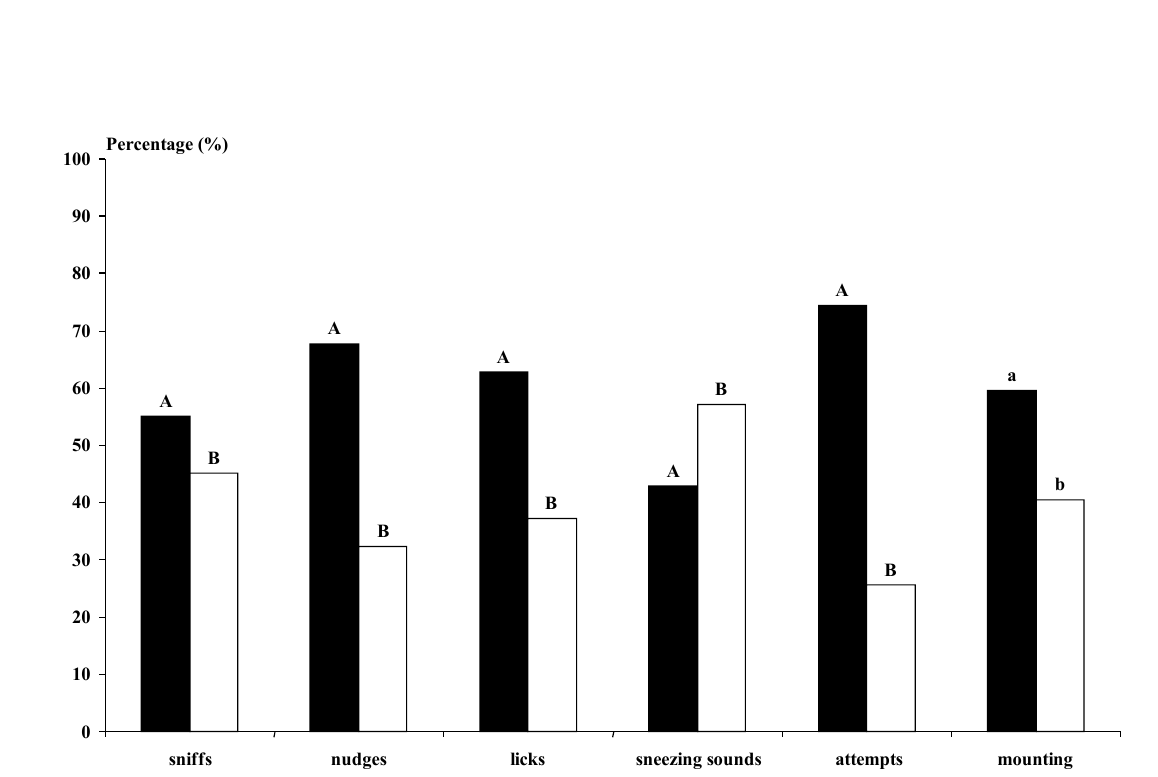
Figure 4. Types of sexual advance (%) performed by the males when females were submitted to the male effect using Murciano–Granadina ( , n = 6) or Blanca Andaluza bucks ( □ , n = 6). Half of each breed group was composed of photoperiod-treated males, and the other half was composed of males subjected to a natural photoperiod. Different letters differ significantly: a, b: ( p < 0.05); A, B: ( p < 0.01). Sniffs (when the buck sniffed the anogenital area of the doe). Licks (when the buck licked the flanks of the doe). Nudges (when the buck kicked the doe). Sneezing sounds (sounds emitted by the bucks). Mounting attempts (when the buck attempted to mount the doe without intromission). Mounting with intromission (when the bucks mounted the doe with